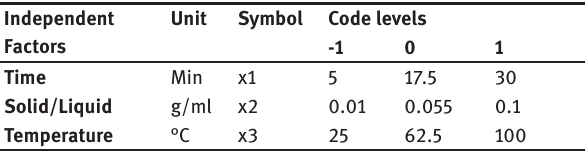
Table 2 : Level and code of independent factors.